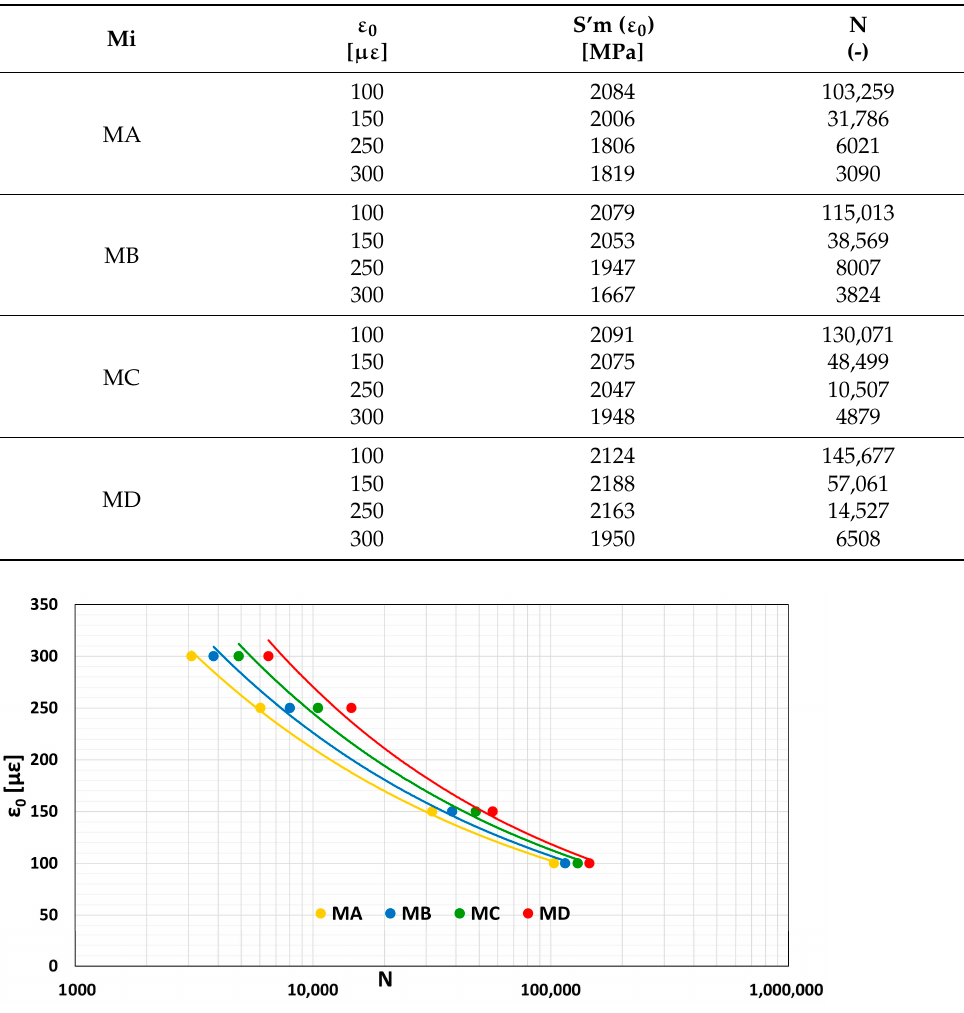
Table 3. Results of the fatigue tests.